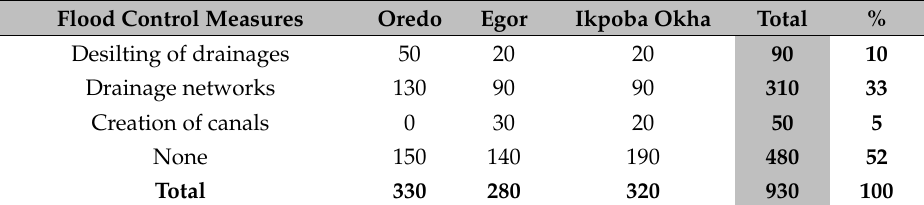
Table 5. Perceived flood control measures by the local government.